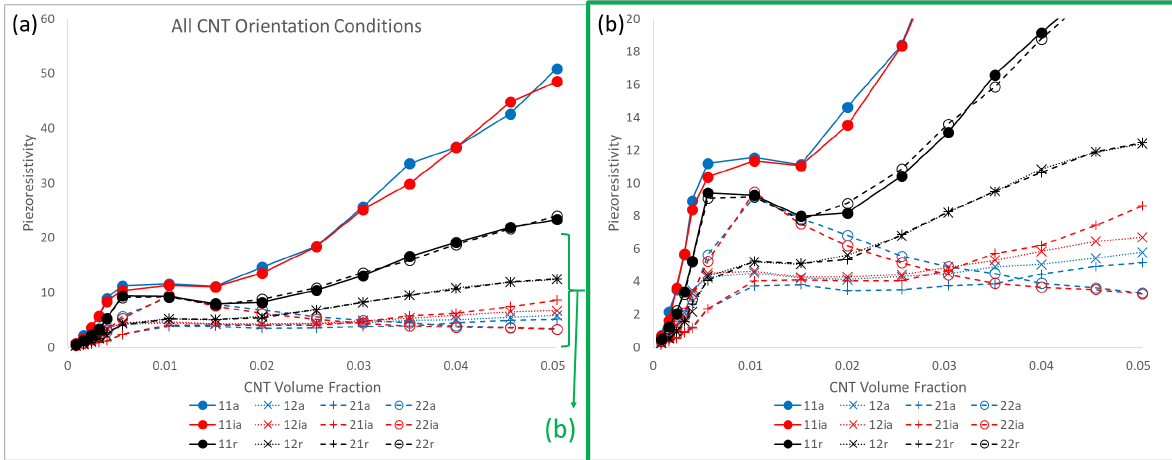
Figure 24. Local conductivity Σ 11 S/m for the ( a ) maximum Σ Ef f 0.24% CNT volume fraction for randomly oriented orientation condition.